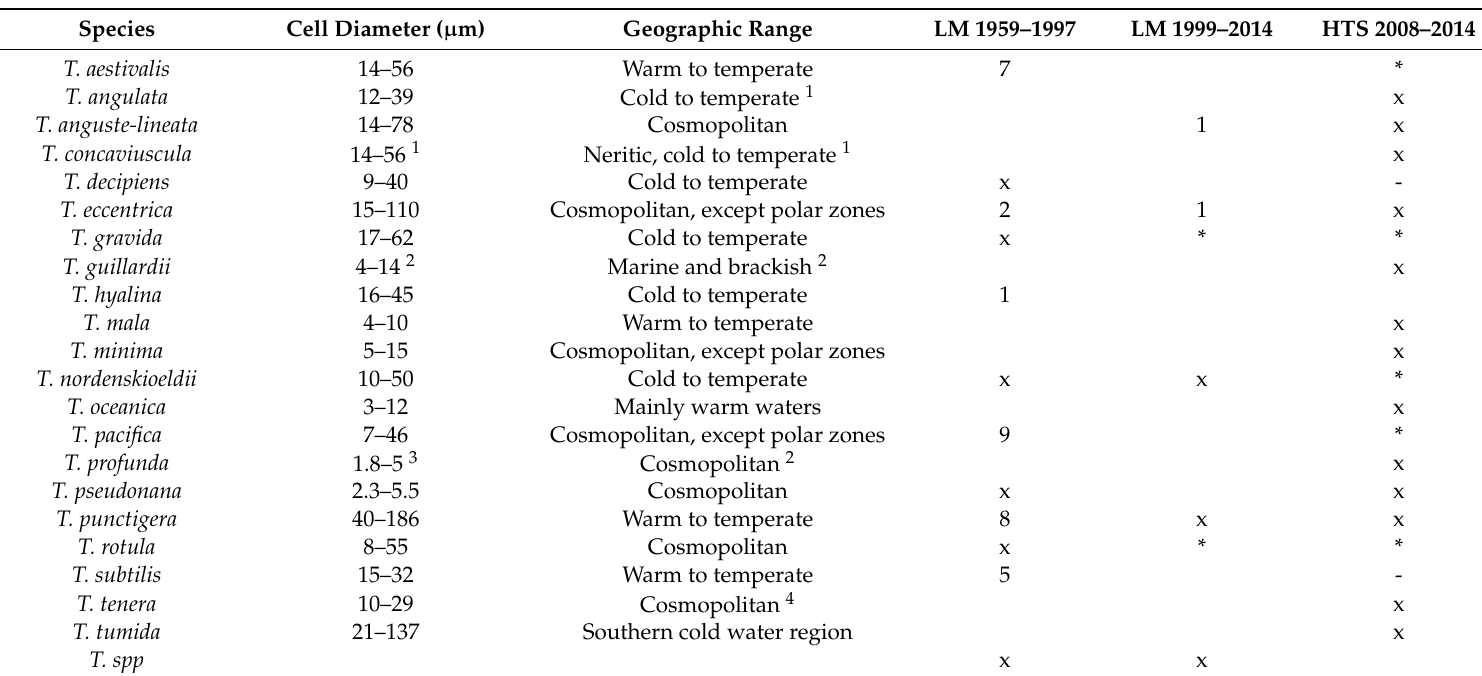
Table 1. Cell diameter and species range from Tomas [29], except where noted, for all Thalassiosira species identified with light microscopy (LM) (1959–1997 [27] and 1999–2014 [26]) and with high-throughput sequencing (HTS) (2008–2014). Species were either identified uniquely (x), identified as part of a group of indistinguishable species (*), not detected because sequence not available in reference database (-) or not detected (blank). Numbers indicating the frequency of observation (no. of weeks observed) are included for rarely occurring species ( ≤ 10 observations) in the light microscopy